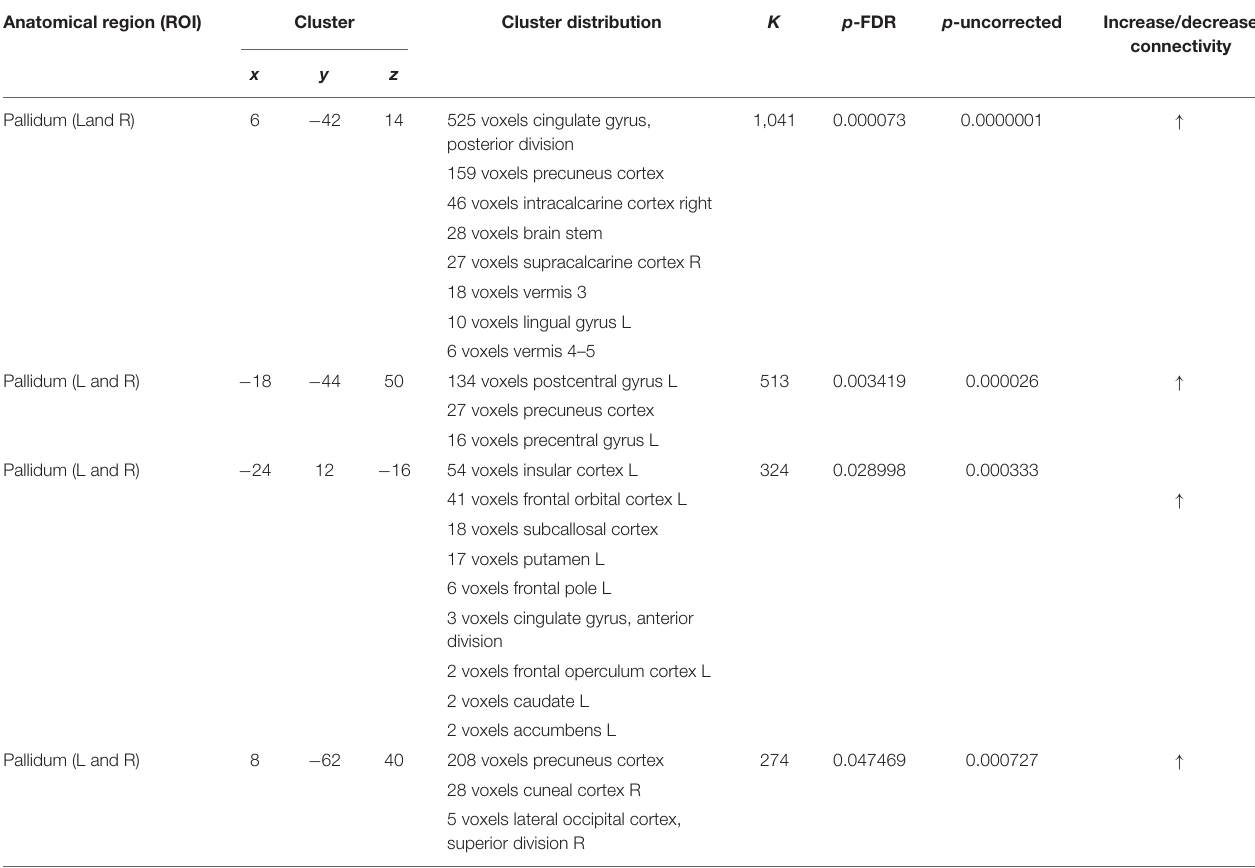
TABLE 2 | Anatomical region of interest with significant connectivity changes.